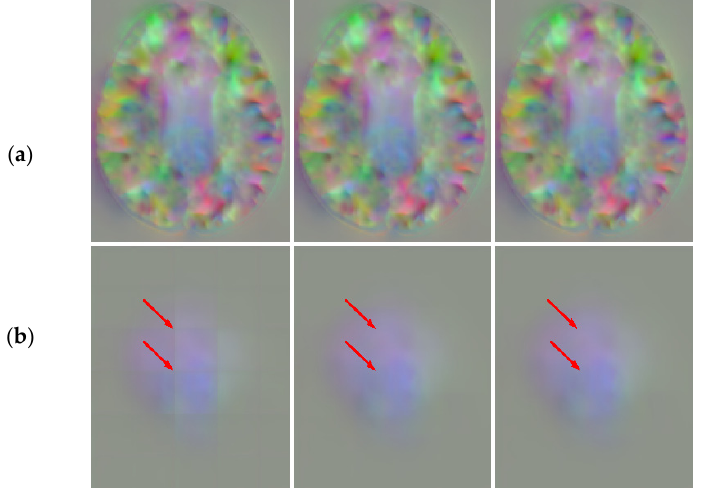
Figure 11. DDFs of three distance functions at 100 slices ( a ) and 160 slices ( b ) of the axial plane. The 1st column is the Chebyshev distance, the 2nd column is the Manhattan distance, and the 3rd col- umn is the Euclidean